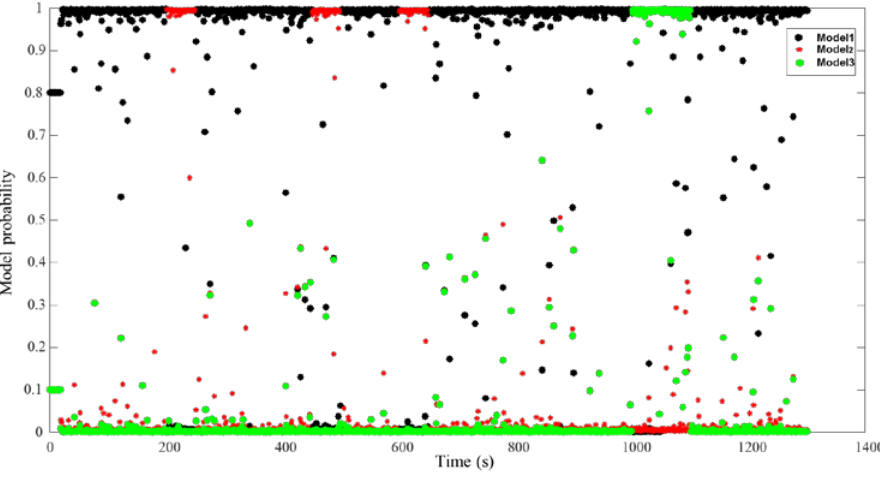
Figure 15. Model probability of IMM.